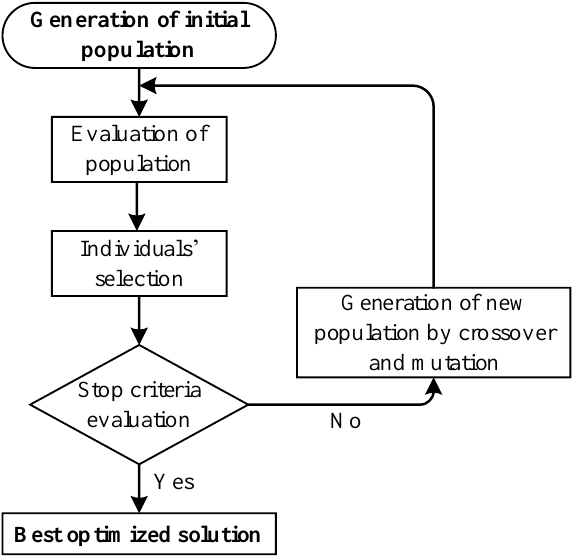
Figure 1. General flow chart of a simple GA structure that is commonly used in engineering appli- cations.